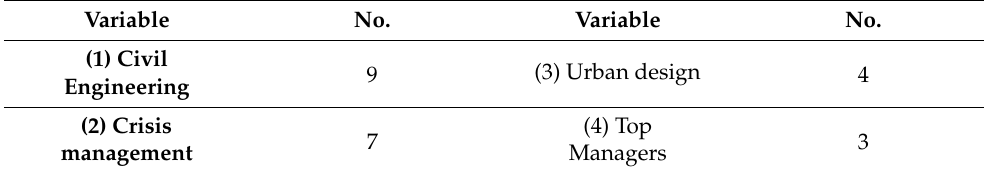
Table 3. Experts group information.